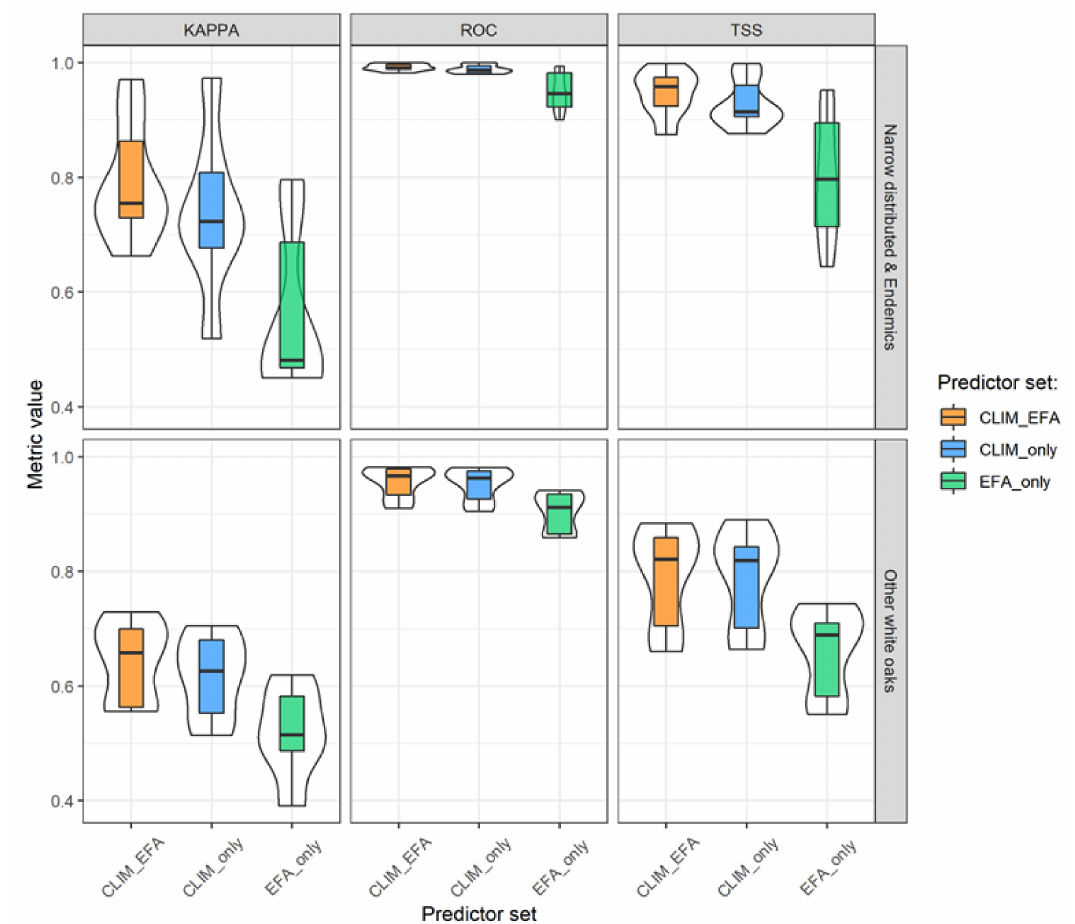
Figure 2. Combined boxplot / violin plot of model performance values for the species group (KAPPA—Cohen Kappa, ROC—area under the receiver operating curve, and TSS—true skill statistic) for each set of predictor variables: “CLIM_EFA” (climate and ecosystem functioning attributes (EFAs) combined), “CLIM_only” (climate variables only) and “EFA_only” (satellite EFA variables only). Boxes display (from bottom to top) the 25%, 50% (median) and 75% quartiles of the distribution. Whiskers present the minimum and maximum